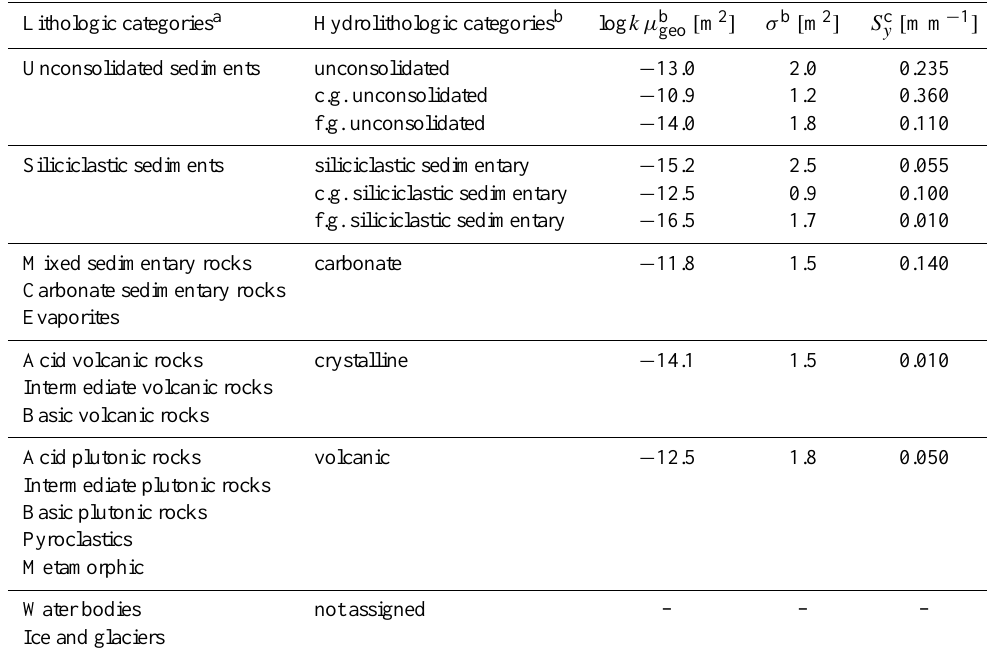
Table 1. Lithologic and hydrolithologic categories. Lithologic categories